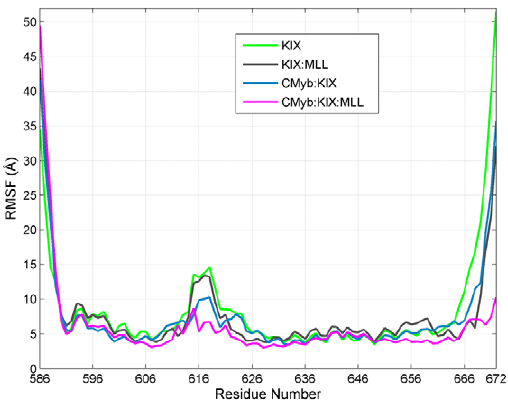
Figure 2. Root Mean Square Fluctuations (RMSF) of KIX from different simulations. The RMSF of KIX residues from the KIX-only (green), KIX:MLL (grey), c-Myb:KIX (blue) and c-Myb:KIX:MLL (pink) simulations. The high RMSF values around Phe612:Lys621 (L 12 and G 2 ) of KIX indicate that this region is the most flexible. Comparing C- Myb:KIX (green) with KIX (blue) and KIX:MLL (red) cases, it can be concluded that c-Myb binding rigidifies this region.